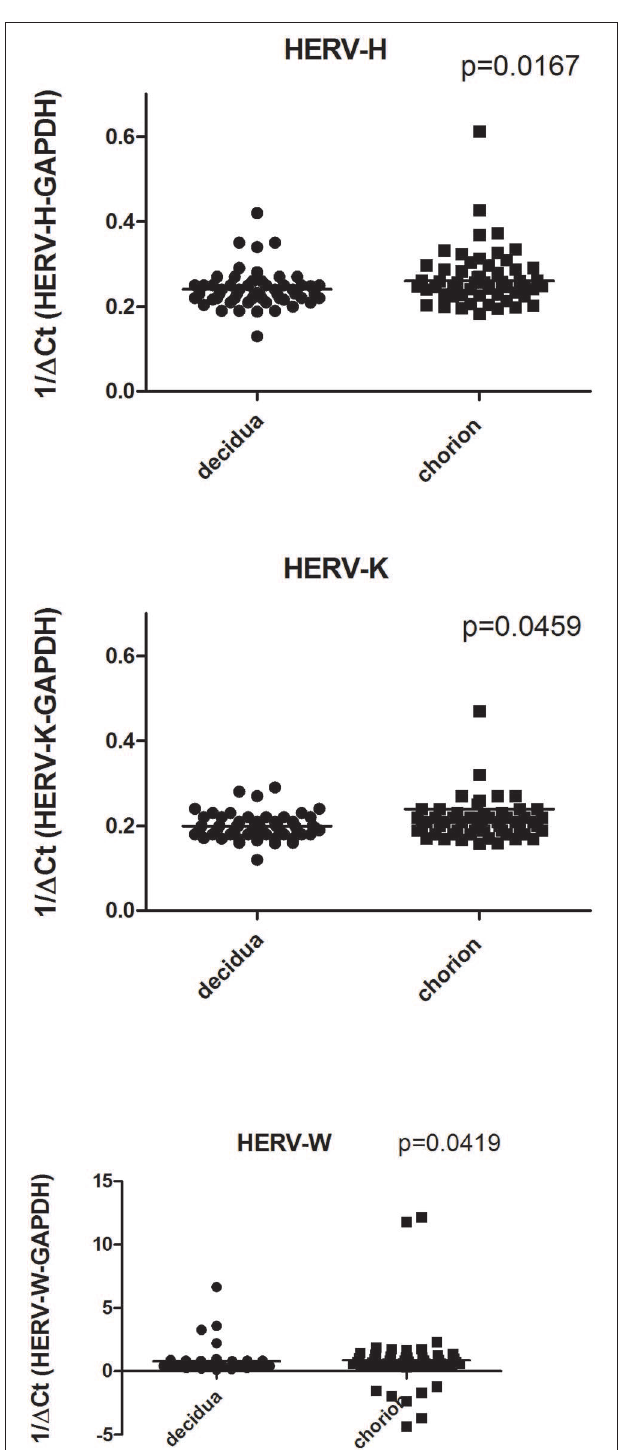
FIGURE 1 | Transcription levels of pol genes of HERV-H, HERV-K, and HERV-W in decidua basalis and chorion from placentae of uneventful, at term pregnancies. Data are represented as black dot. Relative pol levels were assessed by real-time PCR and represented by 1/ 1 Ct. Statistical significance was calculated by Mann-Whitney